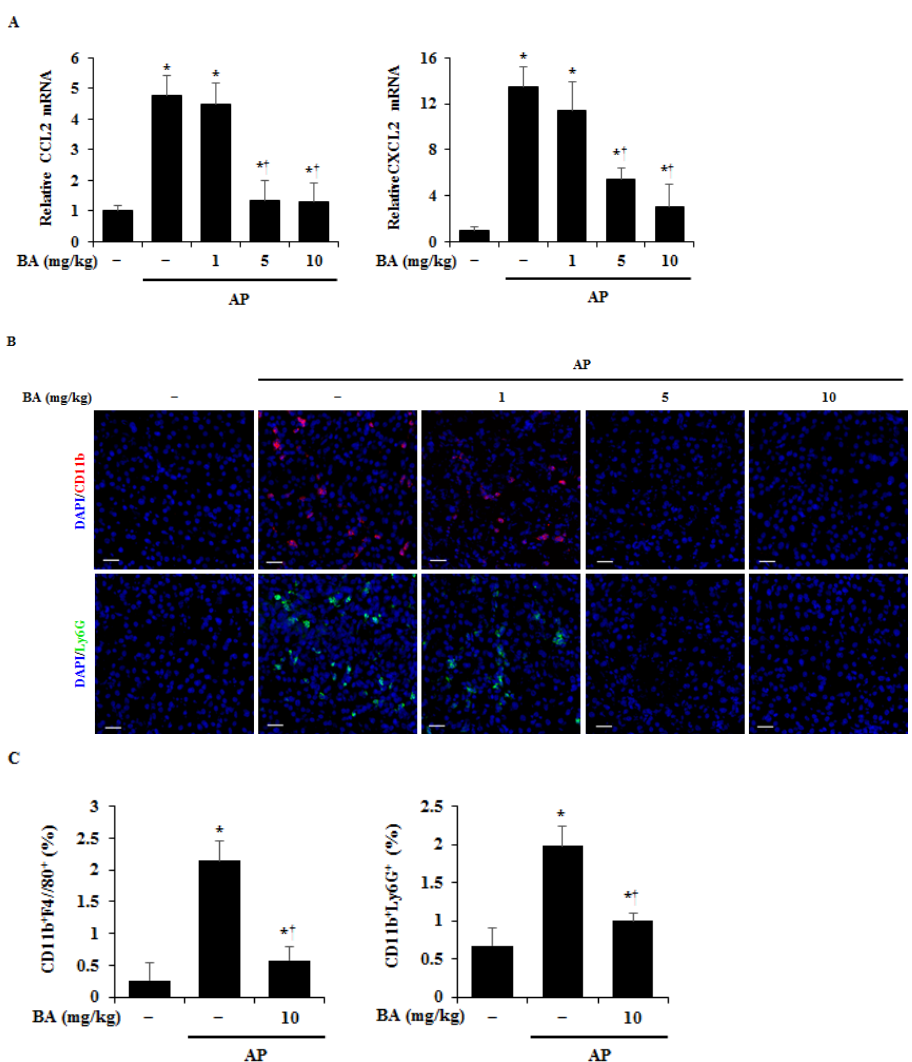
Figure 4. Effect of betulinic acid (BA) on the infiltration of macrophages and neutrophils. ( A ) Pancreatic mRNA levels of chemokine (CC motif) ligand 2 (CCL2) and chemokine CXC motif ligand 2 (CXCL2) were determined using reverse transcription-quantitative polymerase chain reaction (RT-qPCR). ( B ) Confocal images of immunofluorescence staining of CD11b (red), Ly6G (green), and DAPI (blue). Scale bar = 20 µ m. ( C ) Flow cytometry analysis for macrophages (CD11b + F4/80 + ) and neutrophils (CD11b + Ly6G + ). Data are represented as mean ± SEM for six mice in each group. Results are representative of three experiments. * p < 0.05 vs. dimethyl sulfoxide (DMSO) treatment alone. † p < 0.05 vs. cerulein treatment